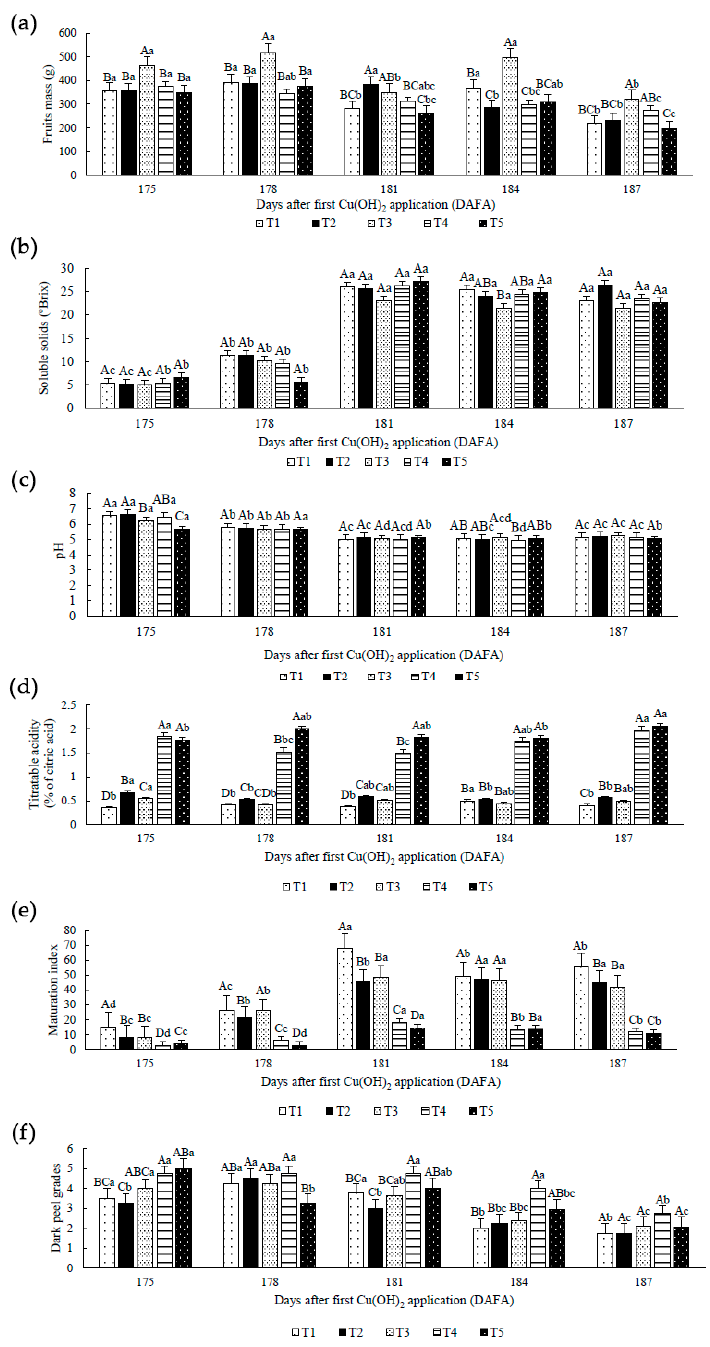
Figure 3. ( a ) Fruits mass (g), ( b ) Soluble solids (°Brix), ( c ) pH, ( d ) Titratable acidity, % of citric acid, ( e ) Maturation index, ( f ) Dark peel grades in 5 evaluations after the first Cu(OH) 2 application in atemoya ( Annona × atemoya Mabb.) fruits cv. Thompson. Medium values. Botucatu, São Paulo, Brazil, 2021. DAFA: Days after the first Cu(OH) 2 application (plants with flowers and fruits in initial stage). T1 (control)—absence of Cu(OH) 2 , T2—7.8 mL Cu(OH) 2 L − 1 of water divided into two applications; T3—15.6 mL Cu(OH) 2 L − 1 of water divided into four applications (the recommended dose by MAPA); T4—8.0 mL Cu(OH) 2 L − 1 of water divided into eight applications; and T5—13.0